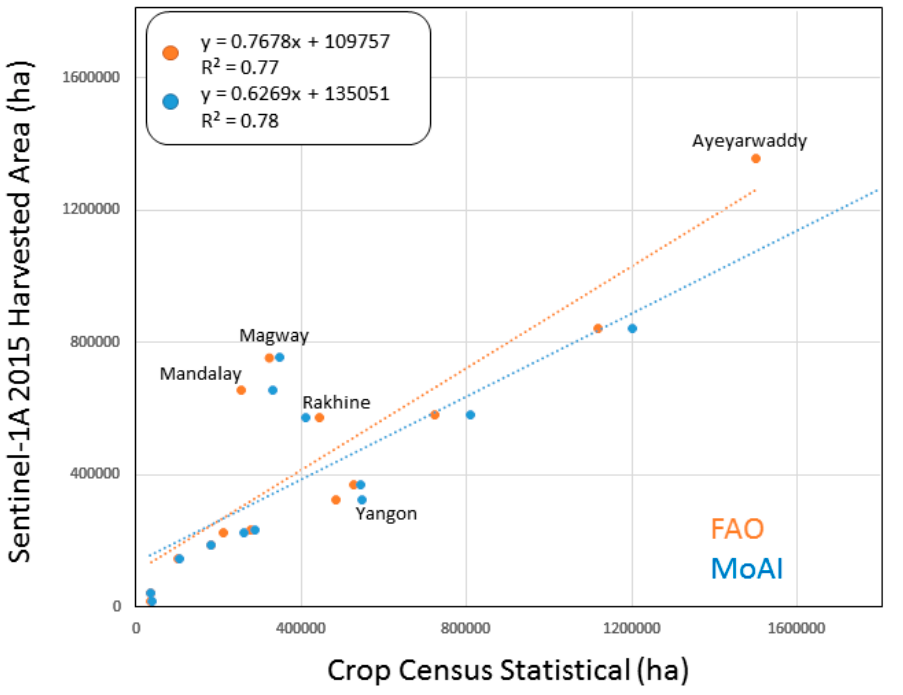
Figure 15. Scatterplot between 2015 census statistics and 2015 Sentinel-1A total harvested rice area shows moderate agreement with discrepancies due to Cyclone Komen disaster flooding and uncertainty in re-planting and accurate reporting.